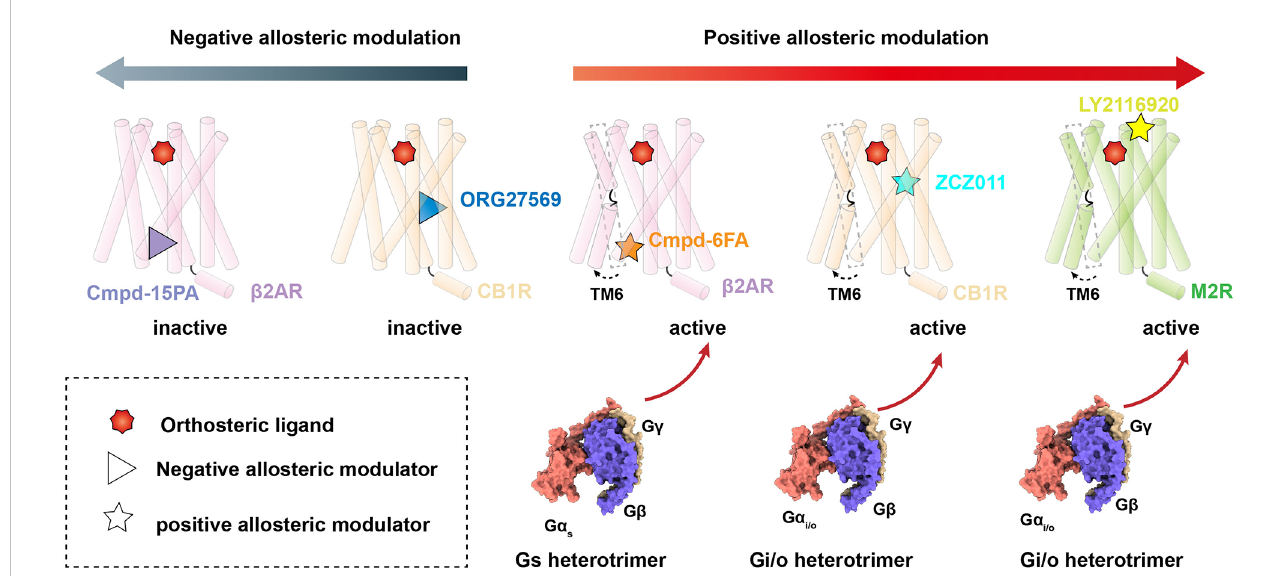
FIGURE 1 Allosteric modulation of Class A GPCRs. Negative allosteric modulation of b 2AR and CB1R signaling transduction (left) and positive allosteric modulation of b 2AR, CB1R and M2R signaling transduction